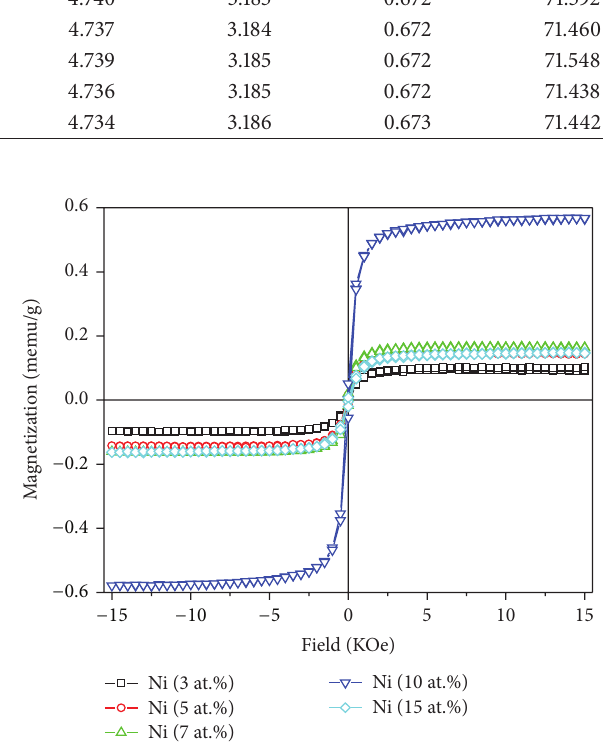
Figure 3: M-H plots of Ni doped SnO 2 powder samples at different Ni dopant